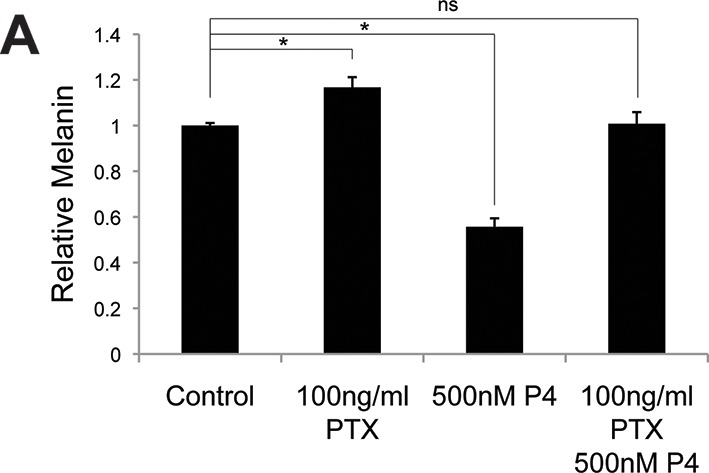
Progesterone signals through Gi in melanocytes.(A) Melanin synthesis in response to Pertussis Toxin (PTX), progesterone (P4), or both. n=3 biologic replicates for each experiment. Error bars denote +/- s.d., *p<0.05DOI: